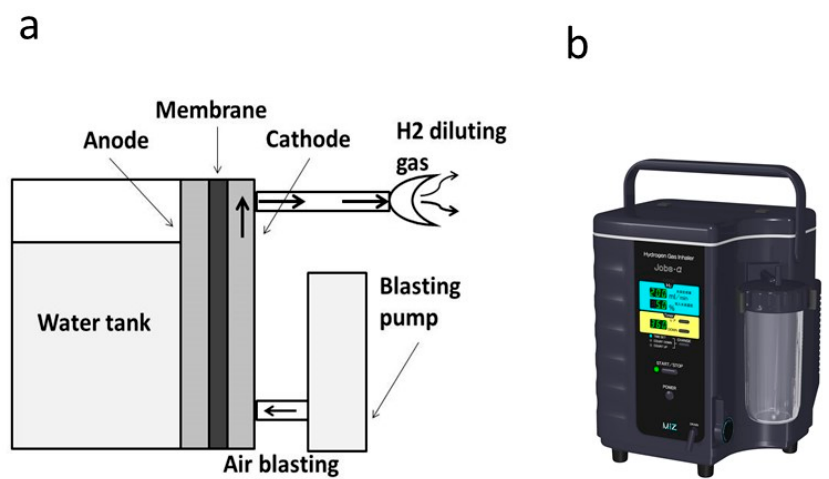
Figure 1. Schematic diagram ( a ) and photograph ( b ) of a hydrogen gas inhaler. The H 2 gas produced by the electrolysis of water on the surface of the cathode is immediately diluted with air to a safe concentration, and the H 2 concentration was maintained at about 5.0%–6.0%.